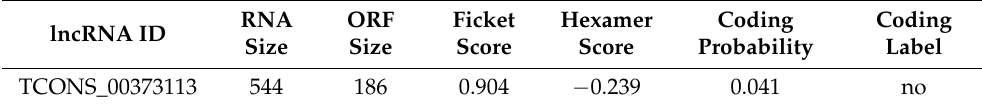
Figure 2. SAAL suppresses IAV regulation in Mle-12 cells. ( A ) HA results of overexpressed lncRNAs together with the control after WSN infection (MOI = 0.5). The viral titer in the supernatant was measured 24 h post infection (hpi). Shown are means for three independent experiments ± SD ( n = 3; ** p < 0.01). ( B ) Plaque assay evaluated the IAV replication after the overexpression of SAAL in Mle-12. Viral titers in supernatants were measured at 24 hpi. The means for three independent experiments ± SD are shown ( n = 3; ** p < 0.01). ( C ) Western blotting evaluated the IAV replication after the overexpression of SAAL in Mle-12 cells. Table 1. Coding ability prediction of lncRNA